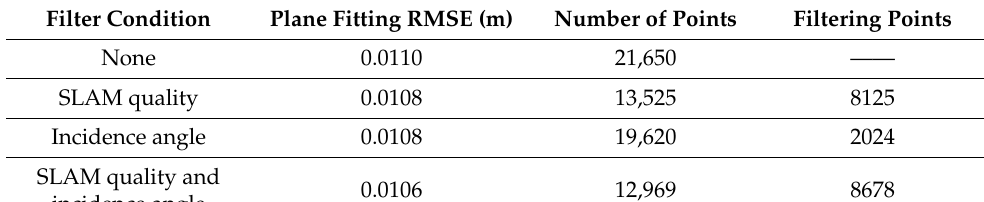
Table 4. Analysis results of filtering conditions using a planar point cloud.